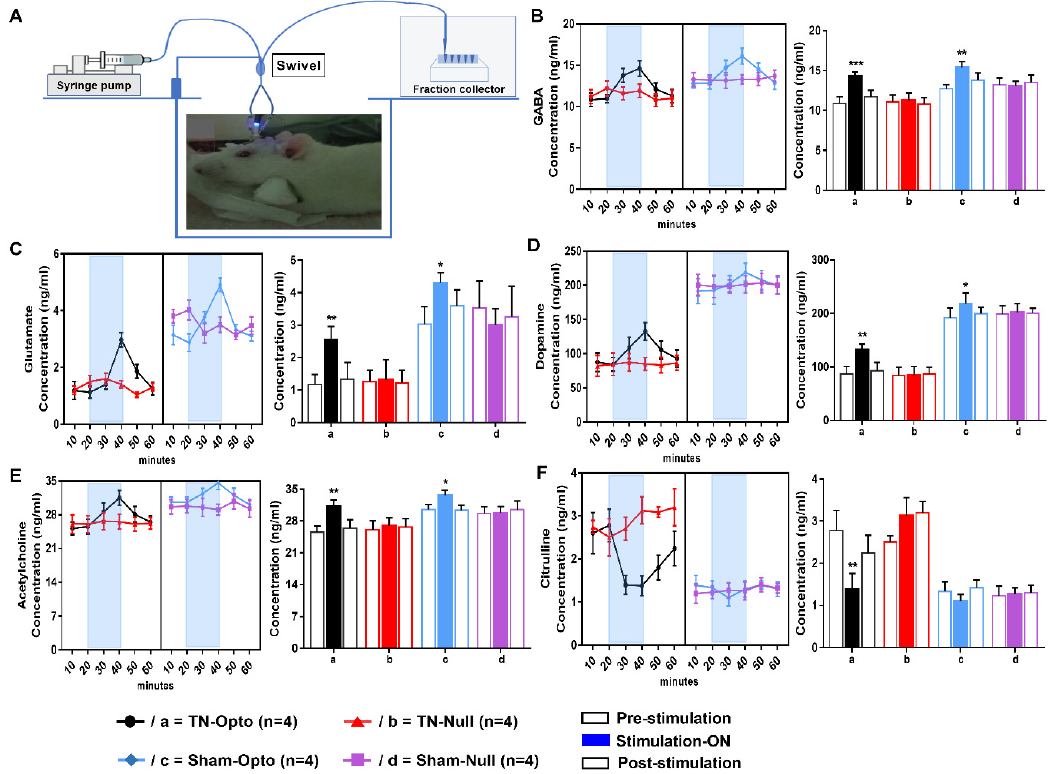
Figure 5. Effect of optogenetic stimulation on the extracellular concentration level of GABA, glutamate, dopamine, acetylcholine, and citrulline in NAcc. ( A ) Microdialysis setup and procedure of microdialysate collection. Extracellular conc. level (ng/mL) of GABA ( B ), glutamate ( C ), dopamine ( D ), acetylcholine ( E ), and citrulline ( F ) throughout the 60 min duration (pre-stimulation: 0–20 min; stimulation “ON”: 20–40 min; post-stimulation: 40–60 min). In both TN-Opto ( n = 4) and Sham-Opto ( n = 4) groups, alterations in the conc. levels of all the five neurotransmitters were observed during optogenetic stimulation but not in the TN-Null ( n = 4) and Sham-Null ( n = 4) animal groups. *, p < 0.05; **, p < 0.01; ***; p < 0.001, significant differences determined using an analysis of variance. Data are represented as means ± SD.